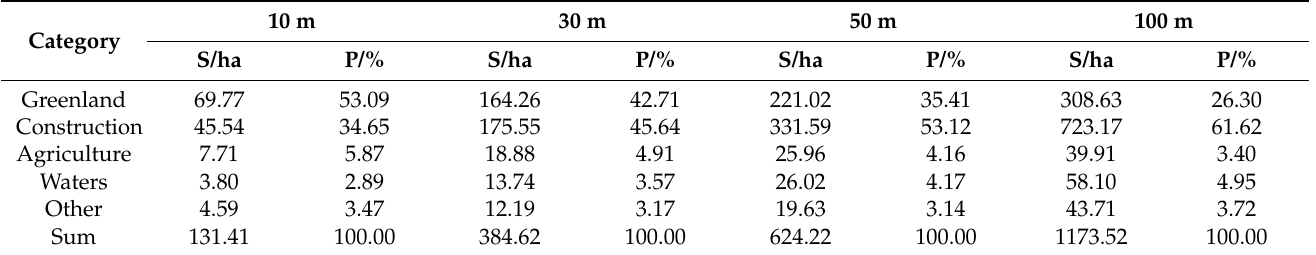
Table 5. Composition of the land class with different buffer zone distances for corridors with Ecotype